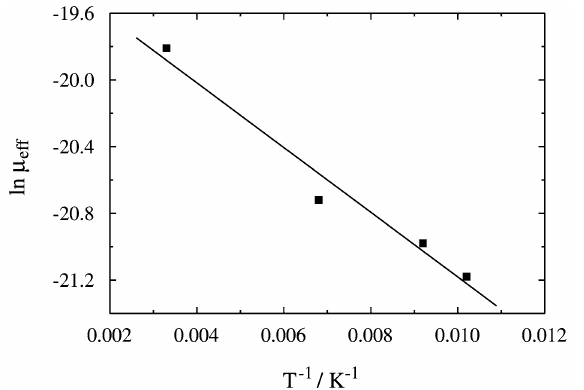
Figure 3. I(V) curve of an Ni/OPPVDBC/Al device. Device area: 1 mm 2 ; OPPVDBC layer thickness: 92 nm; Ni positively biased.